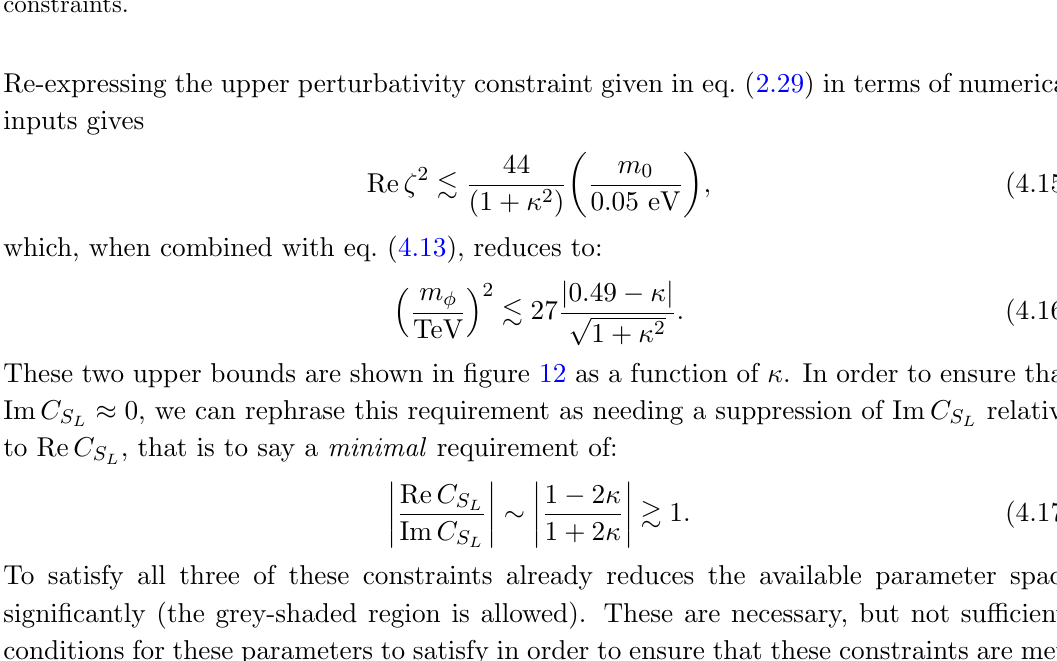
Figure 12. Constraints on neutrino mass Regime 2 ( (cid:30) generating neutrino mass). Coloured lines represent upper bounds on the LQ mass-squared, and the shaded region represents the al- lowed points when also considering suppression of imaginary component of respective Wilson coef- (cid:12)cient C S . The red-dashed line in each indicates the approximate lower mass-bound from collider L